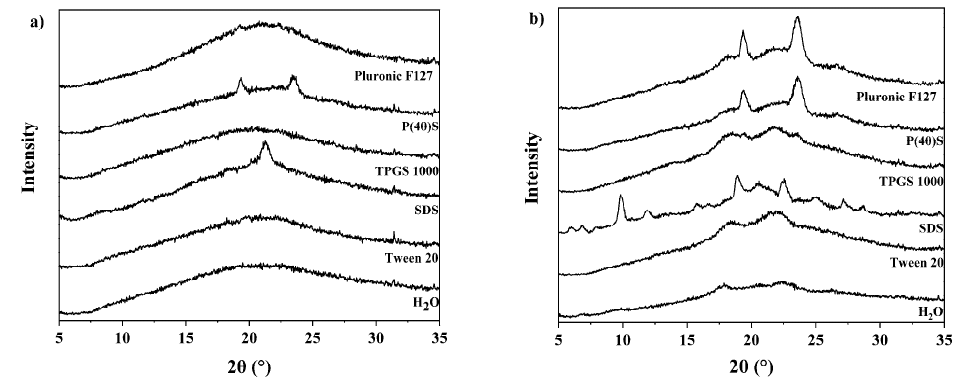
Figure 1. XRPD diffractograms for freshly prepared freeze-dried systems containing naproxen and arginine (NAP-ARG) ( a ) or naproxen and lysine (NAP-LYS) ( b ), respectively, both with surfactant at medium concentration.